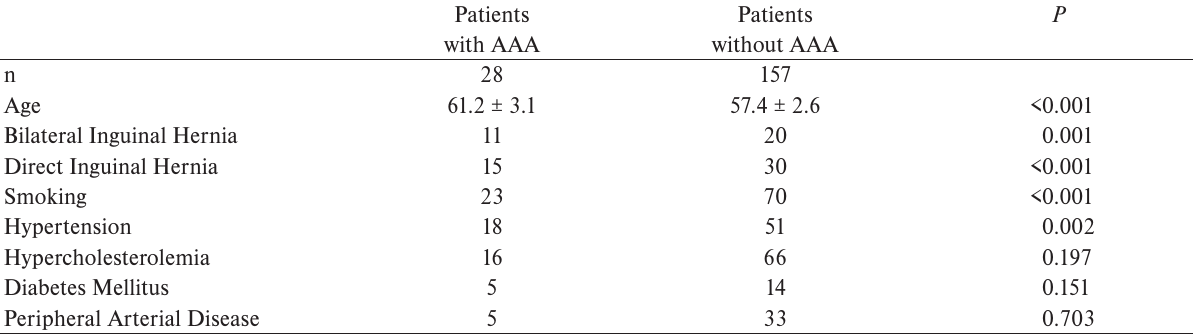
Table 1. Characteristics of patients with inguinal hernia regarding the presence of